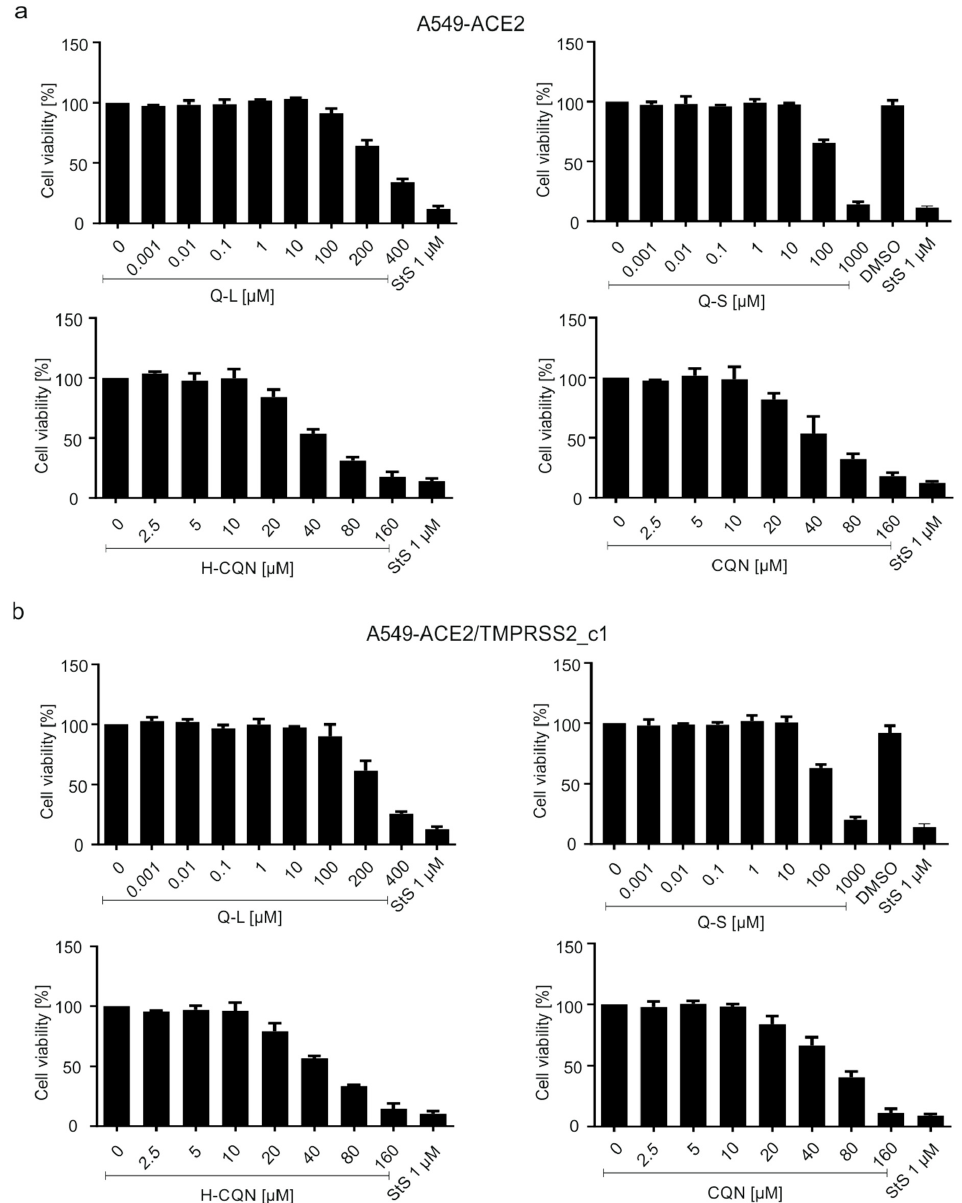
Figure 8. Influence of quinine, H-CQN, and CQN on the cell viability of A549-ACE2 and A549-ACE2/TMPRSS2 cells. Similar to the drug treatment scheme described in Figure 2, the influence on cell viability was measured in ( a ) A549-ACE2 or ( b ) A549-ACE2/TMPRSS2_c1 cells by WST-1 assays. Quinine-sulfate was used as Q-L or Q-S. Bars represent mean values of 3 independent experiments (cid:3399) SD. 3.4. Quinine Inhibits SARS-CoV-2 Infection in Human Calu-3 Lung Cells